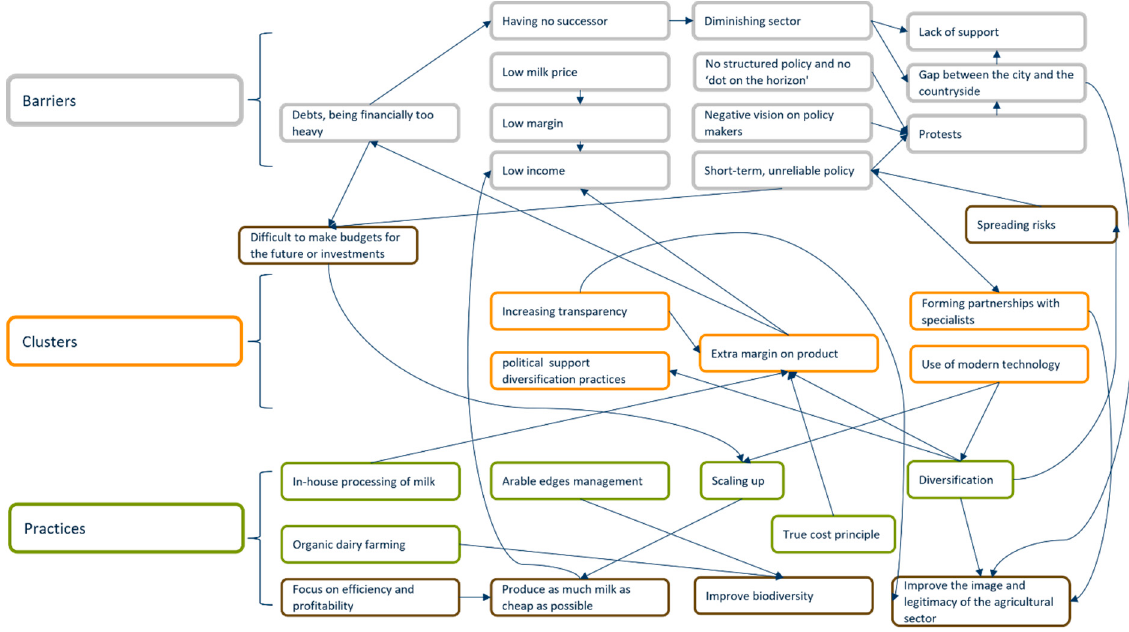
Figure 2. Visualization of the results where the barriers (grey), clusters (orange) and practices (green) are categorized.